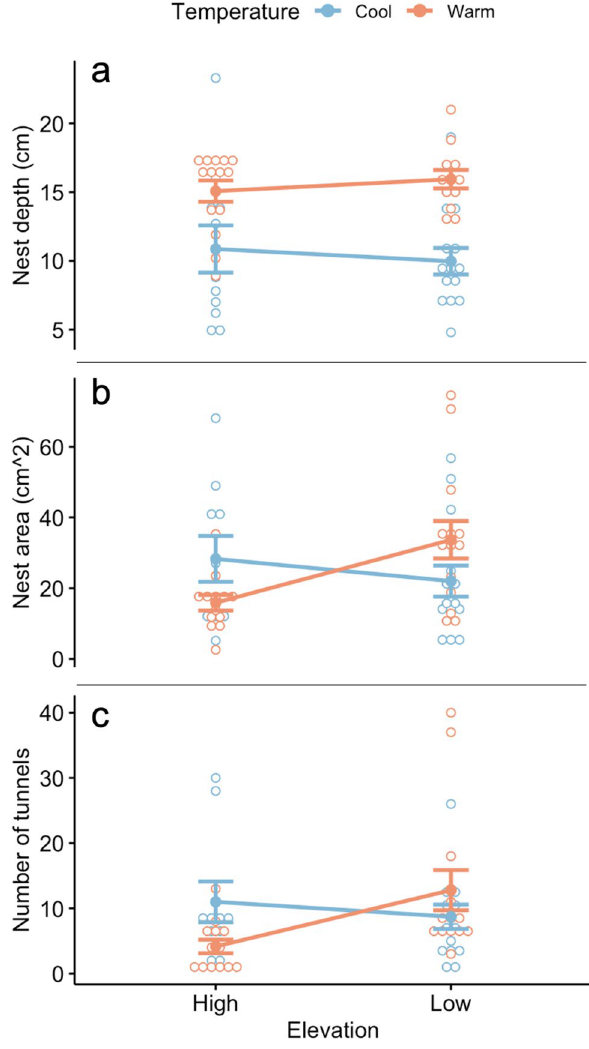
Figure 3. Nest depth ( a ), area of soil excavated ( b ), and the number of tunnels ( c ) excavated by low- and high-elevation workers under cool (blue) and warm (red) temperature treatments. Each dot represents one observation, and error bars show standard error. Workers experiencing the warm treatment excavated significantly deeper nests than those under the cool treatment, while the tunnel area and the number of tunnels depended on the interaction between the workers’ native elevation and the temperature